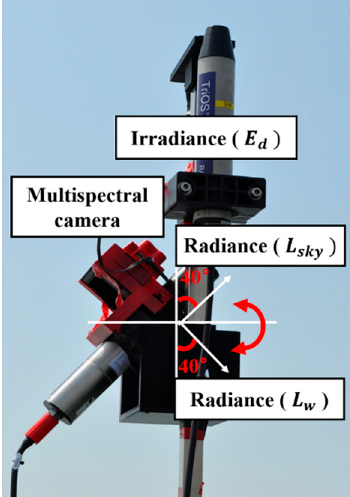
Figure 3. RAMSES hyperspectral radiometer and RedEdge multispectral camera. Both sensors measure downwelling spectral plane irradiance (E d ), sky radiance (L sky ) and total upwelling radiance (L w ) to estimate reflectance ( R rs ), as discussed in Section 4.2.